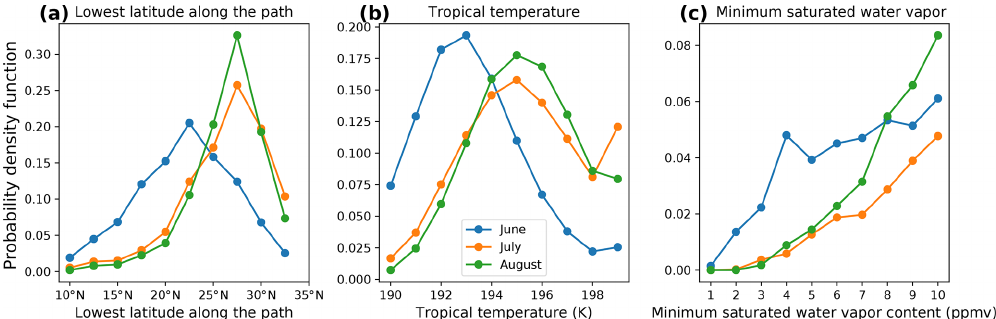
Figure 4. (a) PDF of lowest latitude. (b) Daily tropical temperature (K) obtained from ERAi (0–20 ◦ N, 70–130 ◦ W). (c) PDF of minimum saturated water vapor (ppmv). The minimum saturated water vapor mixing ratio and the lowest latitude are the minimum values along the path after the parcels encounter deep convection in the back trajectory model and prior to being observed by MLS.